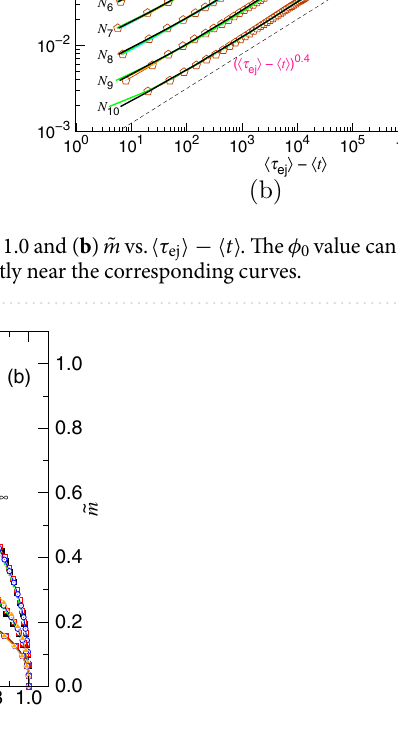
Figure 11. ( a ) m vs. number of monomers plotted in the normalized coordinates in the